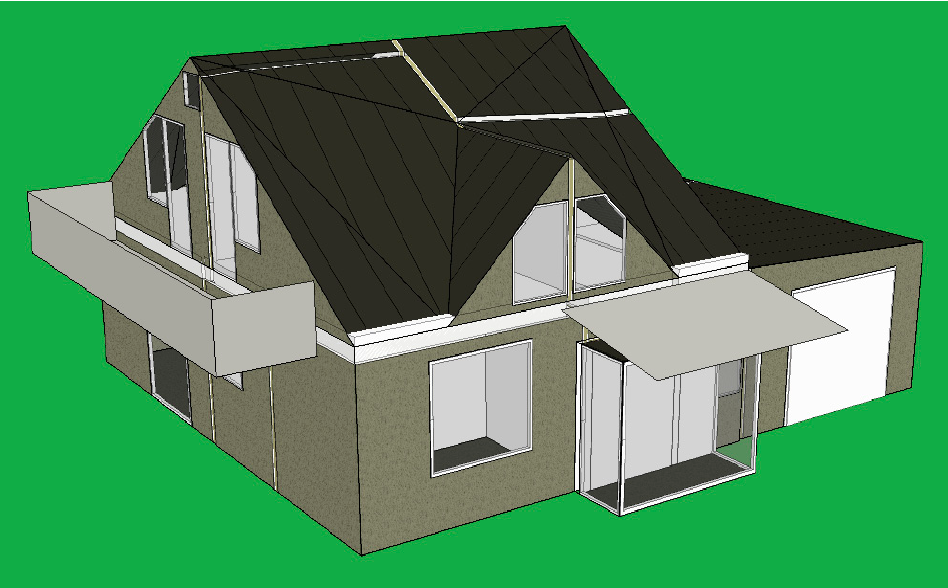
Figure 1. Single-family residential house building example model.